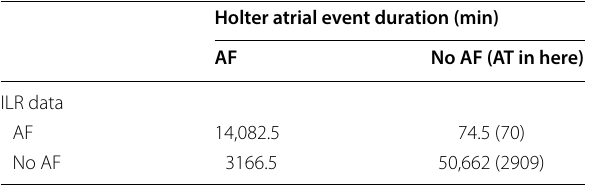
ILR implantable loop recorder, AF atrial fibrillation, AT atrial